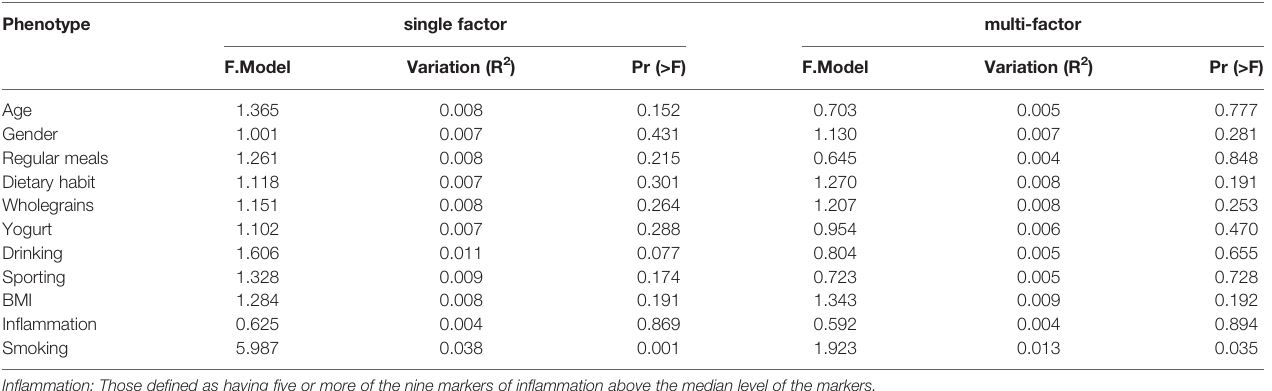
TABLE 2 | In fl uence of participants ’ basic attributes on micro fl ora structure.